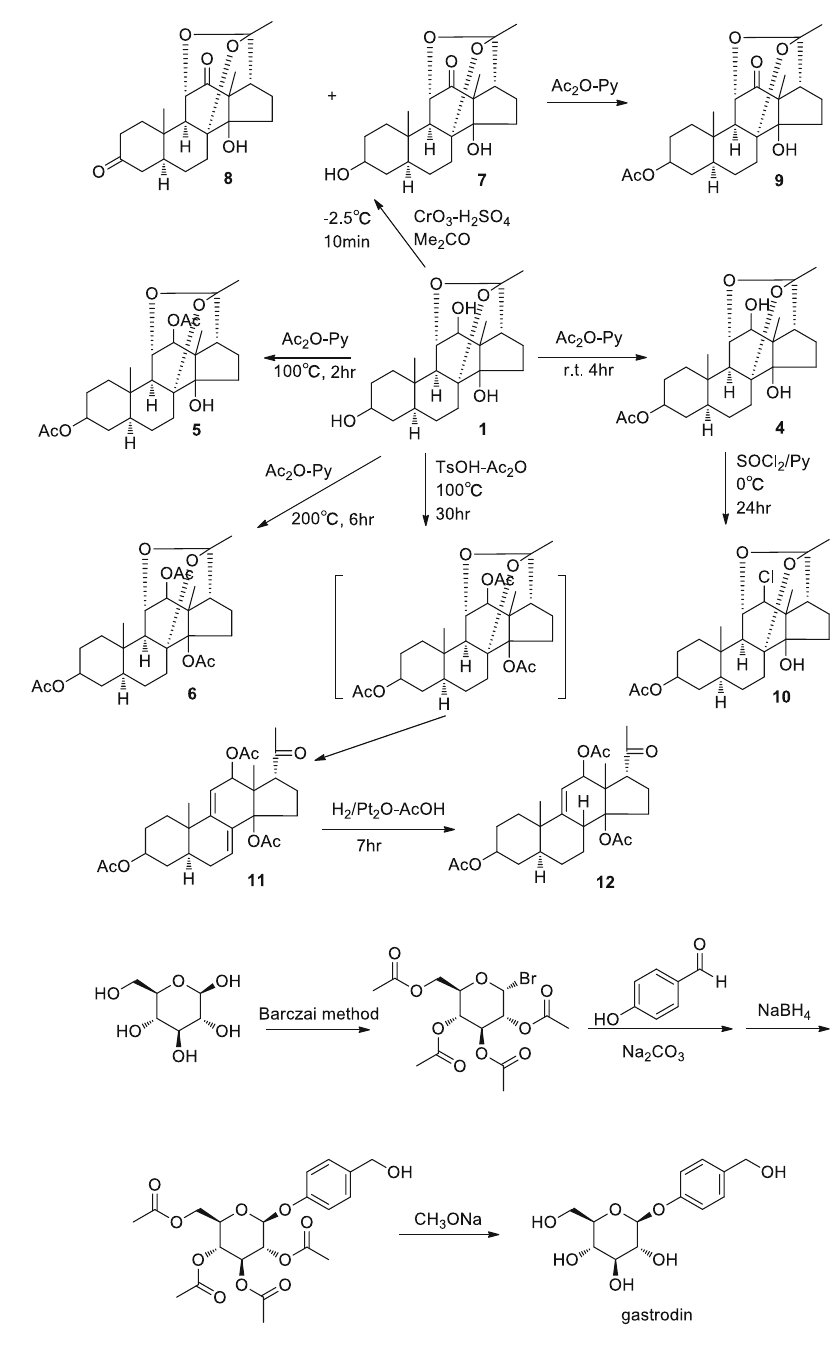
Fig. 7 Total synthesis route of gastrodin at the